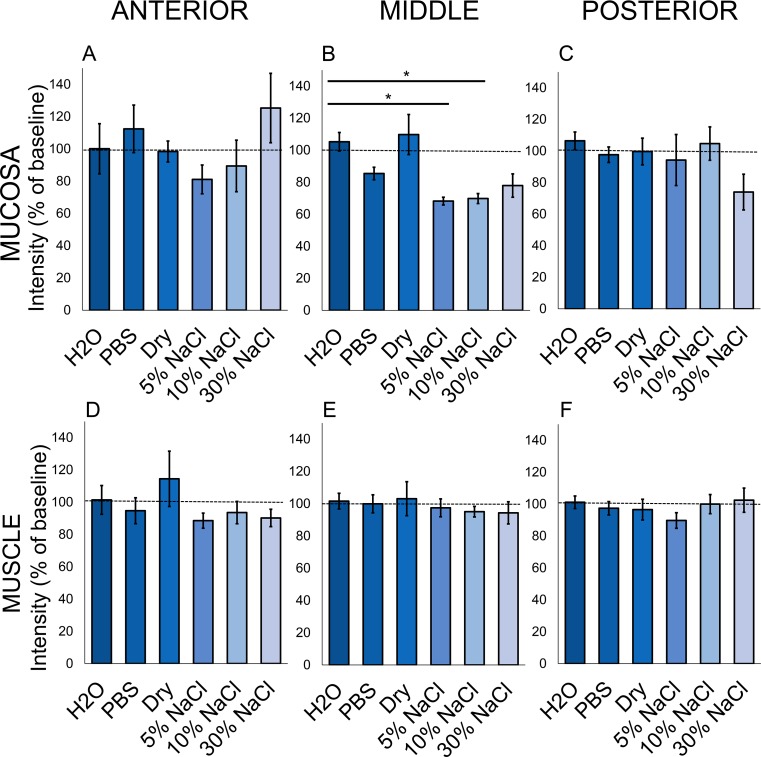
Intensity in vocal fold mucosa and thyroarytenoid after immersion in hypo-, iso-, and hypertonic solutions.Intensity (% of baseline) as a function of immersion solution in mucosa (A-C) and in thyroarytenoid muscle (D-F). Data plotted as mean ± SEM. n = 5 larynges per group. Pairwise comparison using Games-Howell test: *p<0.05.